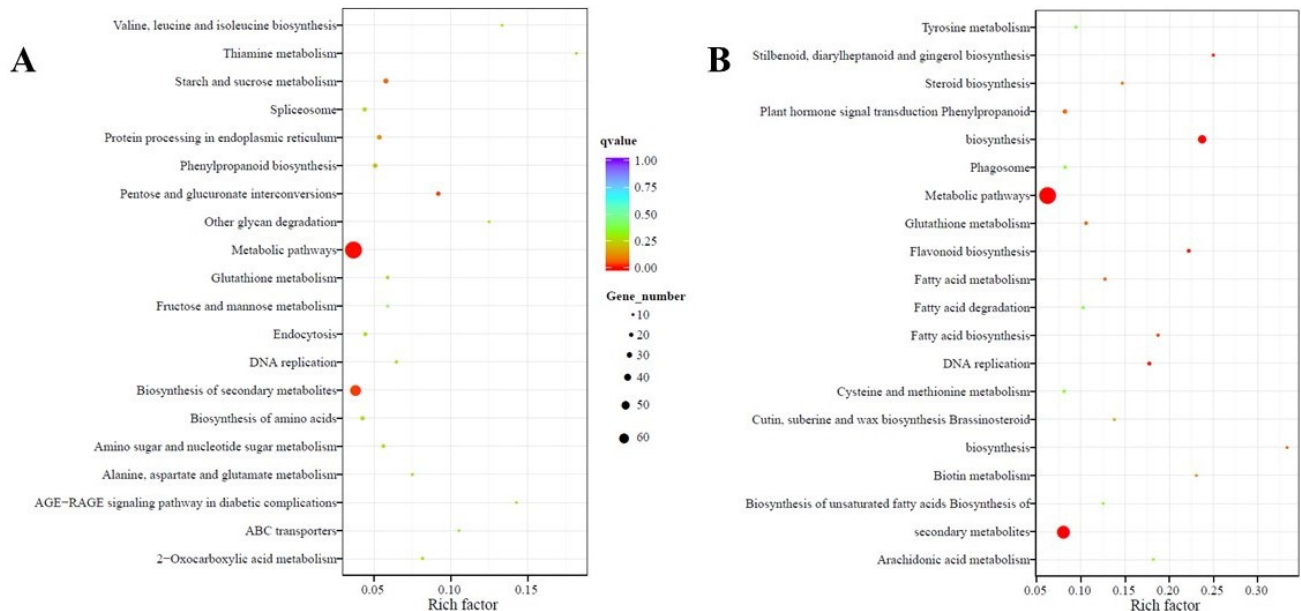
Figure 6. Statistics of pathway enrichment. The KEGG enrichment scatter plot analysis shows enriched pathways for ( A ) up and ( B ) downregulated differentially expressed genes (DEGs) in root tissue of PI 175311. The Rich factor is the ratio of DEGs in this pathway term to all gene numbers annotated in this pathway term. A q-value is the corrected p -value ranging from 0 to 1, and a lower value indicates greater pathway enrichment. The pathway names are shown on the y -axis, rich factor on the x -axis, size of the point represents the number of DEGs, and the color of the dot represents the